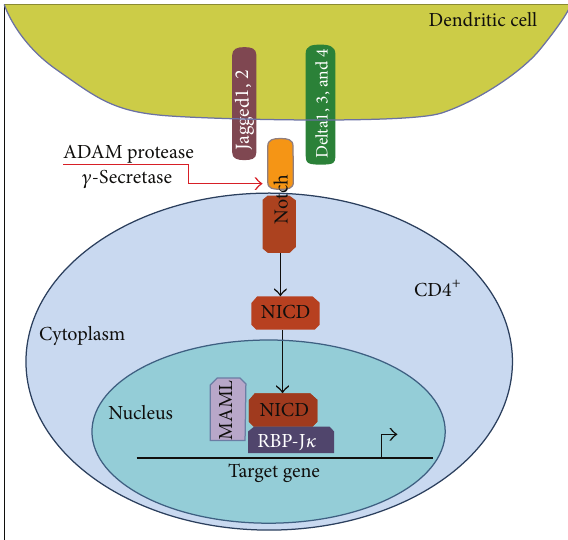
Figure 1: Schematic illustration of Notch signaling pathway. Bind- ing of the extracellular part of Notch receptor to ligands of the Delta and Jagged families induces proteolytic cleavage of Notch, releasing the intracellular part of the protein (NICD). NICD is then translocated to the nucleus and binds to the nuclear transcription factor RBP-J 𝜅 inducing its conversion from a repressor into an activator to stimulate the transcription of Notch target genes.